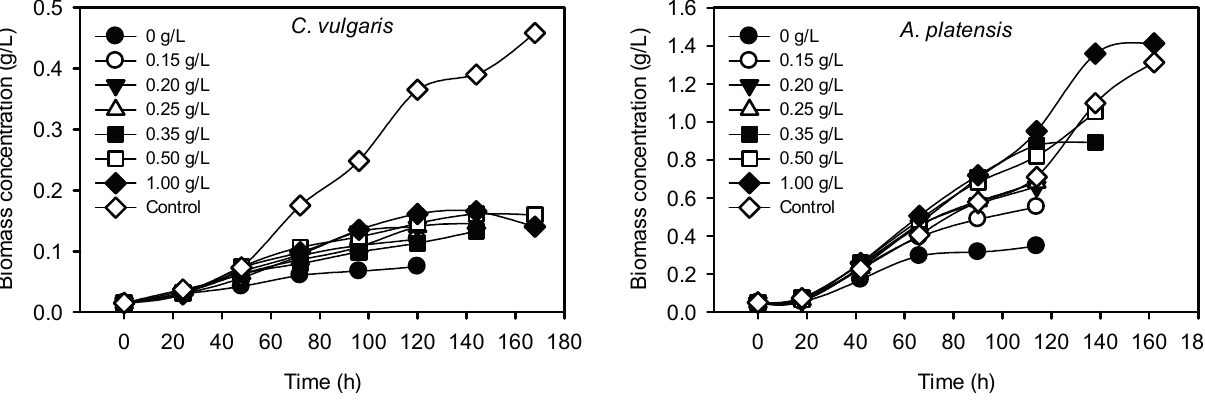
Figure 3. Biomass production during the cultivation of C. vulgaris and A. platensis in cultivation media supplemented with 0.15–1.00 g/L P-loaded zeolite as P